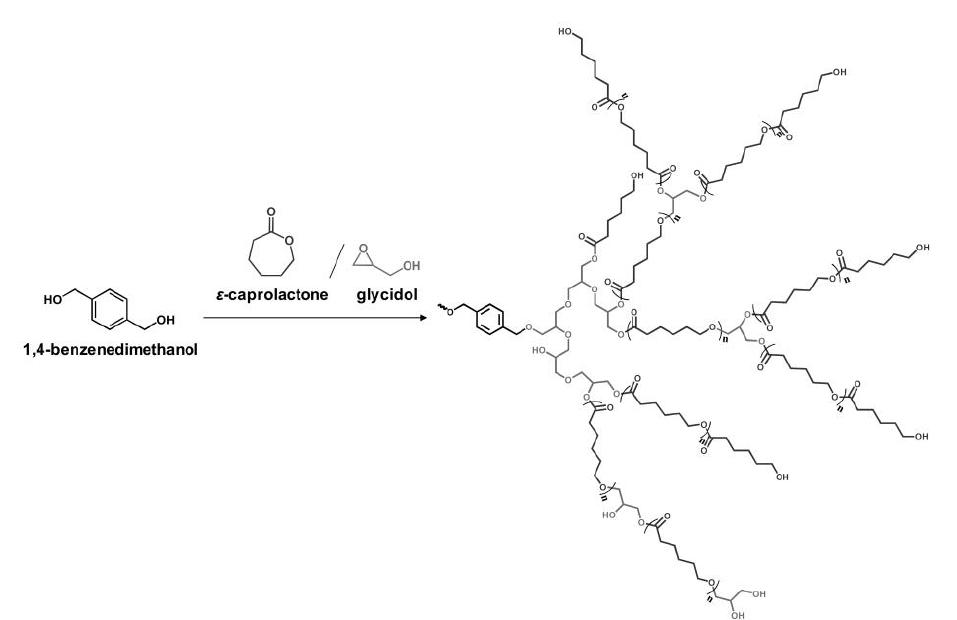
Figure 9. Synthesis of butyl-esterified highly branched polycaprolactone.